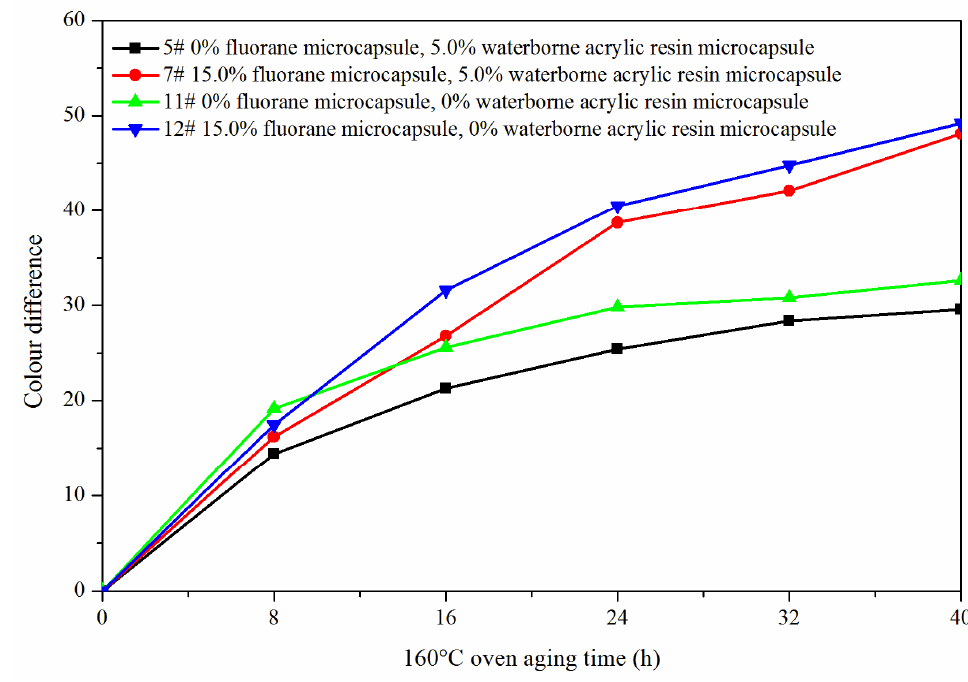
Figure 14. Effect of aging time on color difference of film at 160 °C in oven.